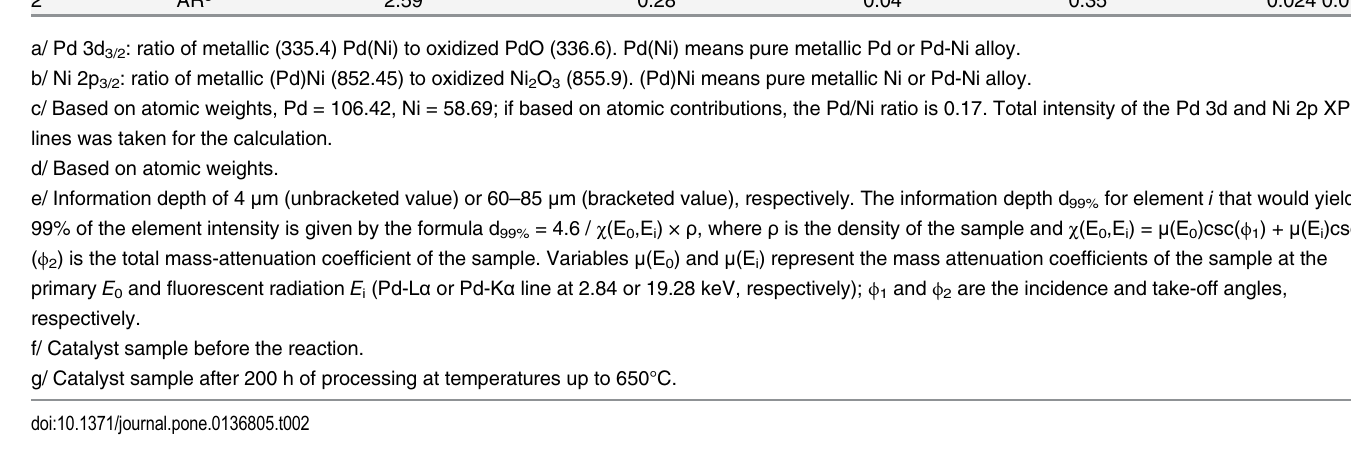
Table 2. XPS peak positions (binding energy in eV) and relative intensity ratios of the metallic and oxidized components of the nano-Pd/Ni (t-Ni) catalyst before (BR) and after (AR) reaction. Sample